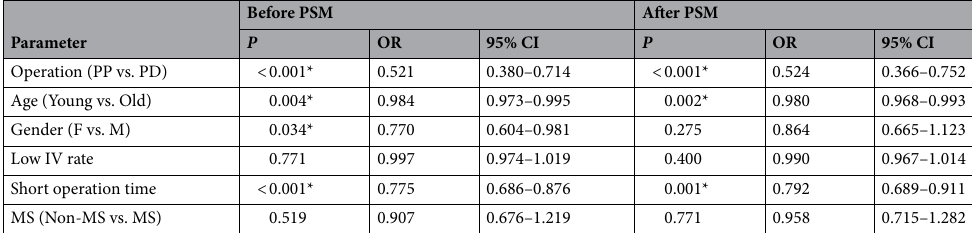
Table 4. Covariates and MS on postoperative composite complications after pancreatic surgery. * P value was less than 0.05, with statistical significance. MS: Metabolic syndrome. Operation (PP vs. PD): Operation of partial pancreatectomy versus operation of pancreatoduodenectomy; Gender (F vs. M): Female versus male in term of gender; Age (Young vs. Old): Young age versus old age; Low IV rate: low intravenous infusion rate; Short operation time: short duration of operation time.